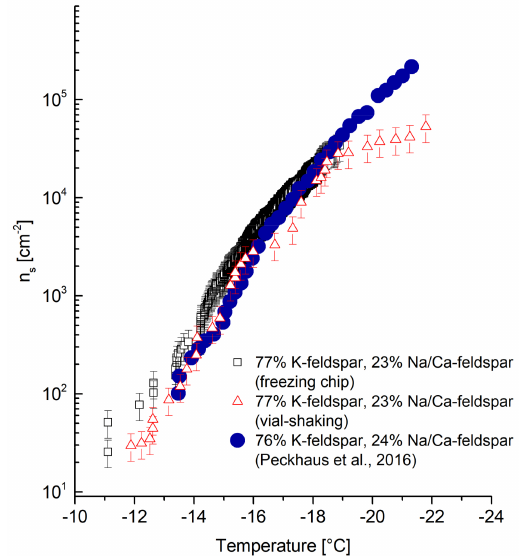
Figure 5. The ice nucleation active surface site densities ( n s ) of microcline determined with the freezing chip compared to measurements performed with the vial-shaking technique and already published data [17]. The error bars of the n s values originate from the estimation of the corresponding droplet diameter of 40 µ m ± 10% and weighing